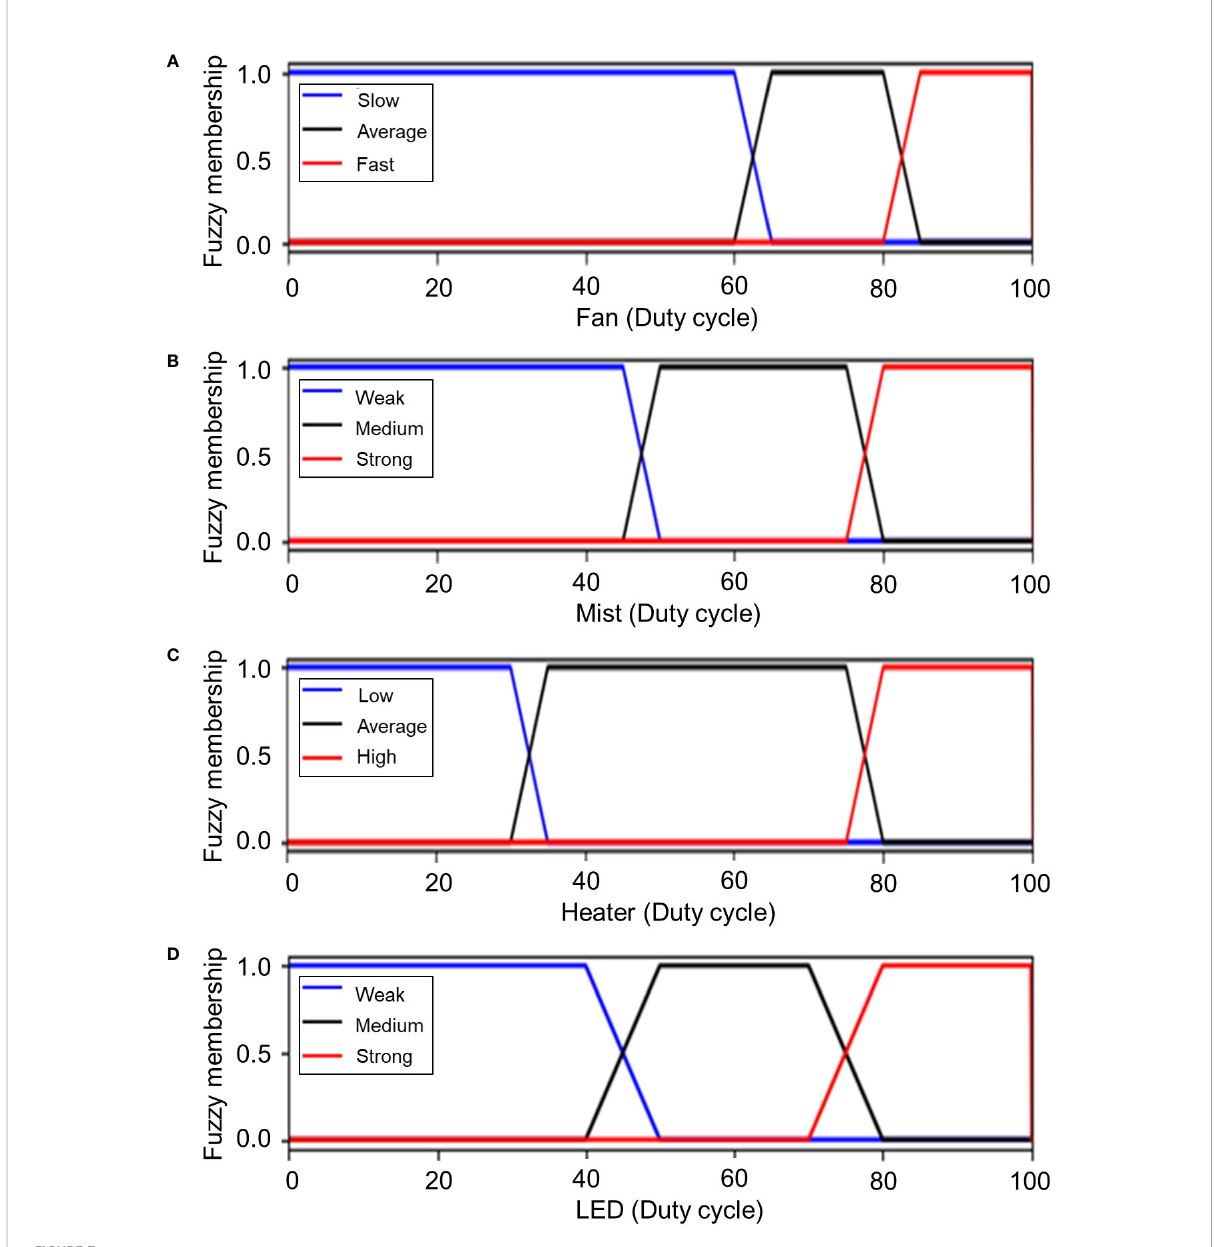
FIGURE 7 Membership functions of output variables. (A) Fan, (B) humidi fi er, (C) heater, and (D)